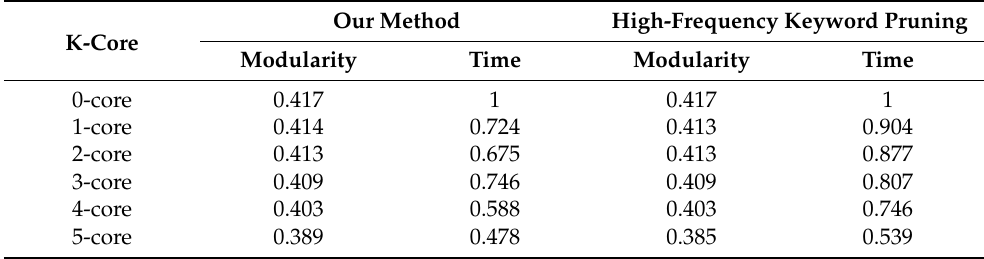
Table 4. Relative run time and